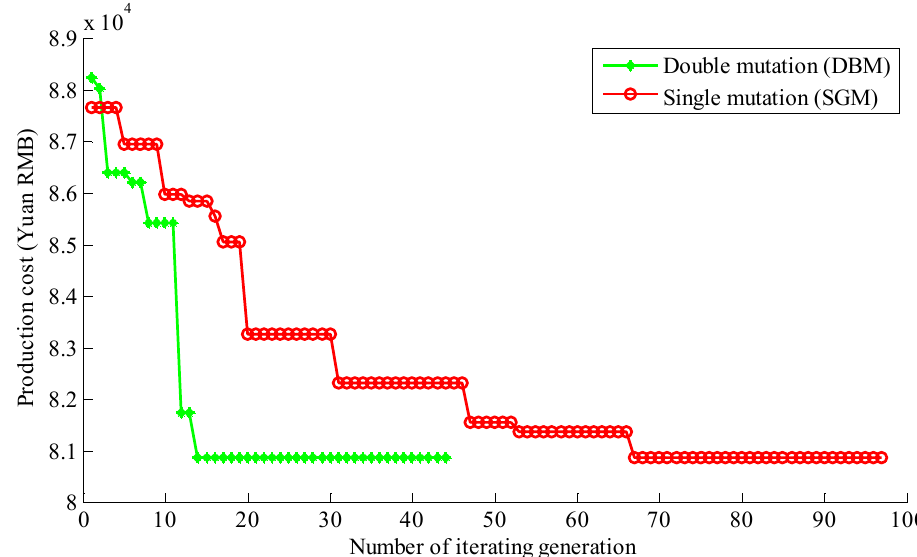
Figure 7. Convergence curves of the optimal solutions to configurations C4 × 6&DBM and C4 × 6&SGM.